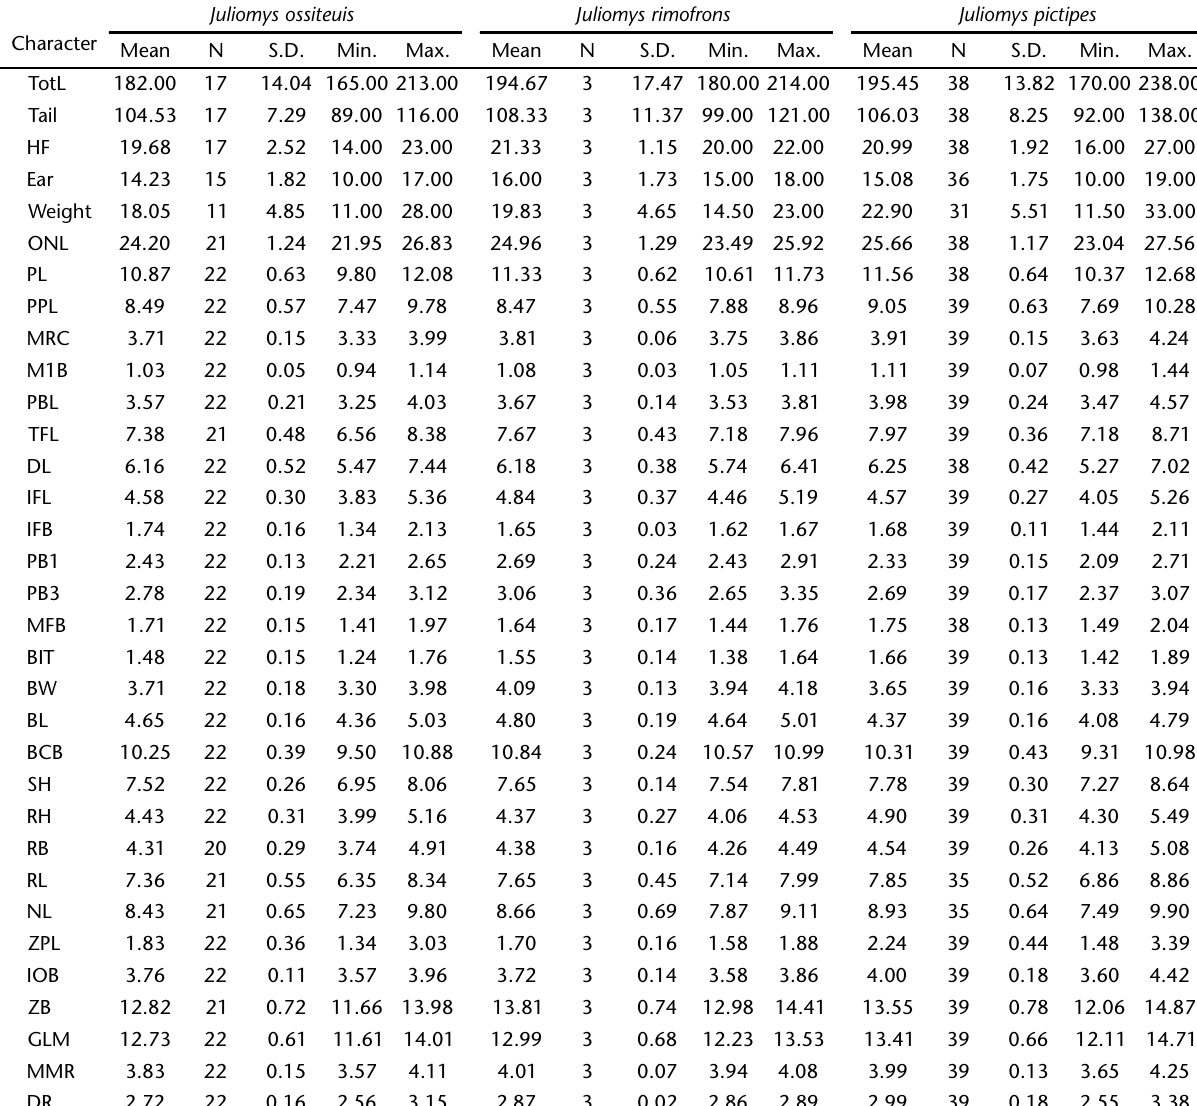
Table II. Descriptive statistics for measurements (mm) and weight (g) of adult (dental age classes 2-4) specimens of Juliomys , grouped by species. (N) Sample size, (S.D.) Standard Deviation, (Min) minimum, (Max) maximum. For other abbreviations see material and methods.